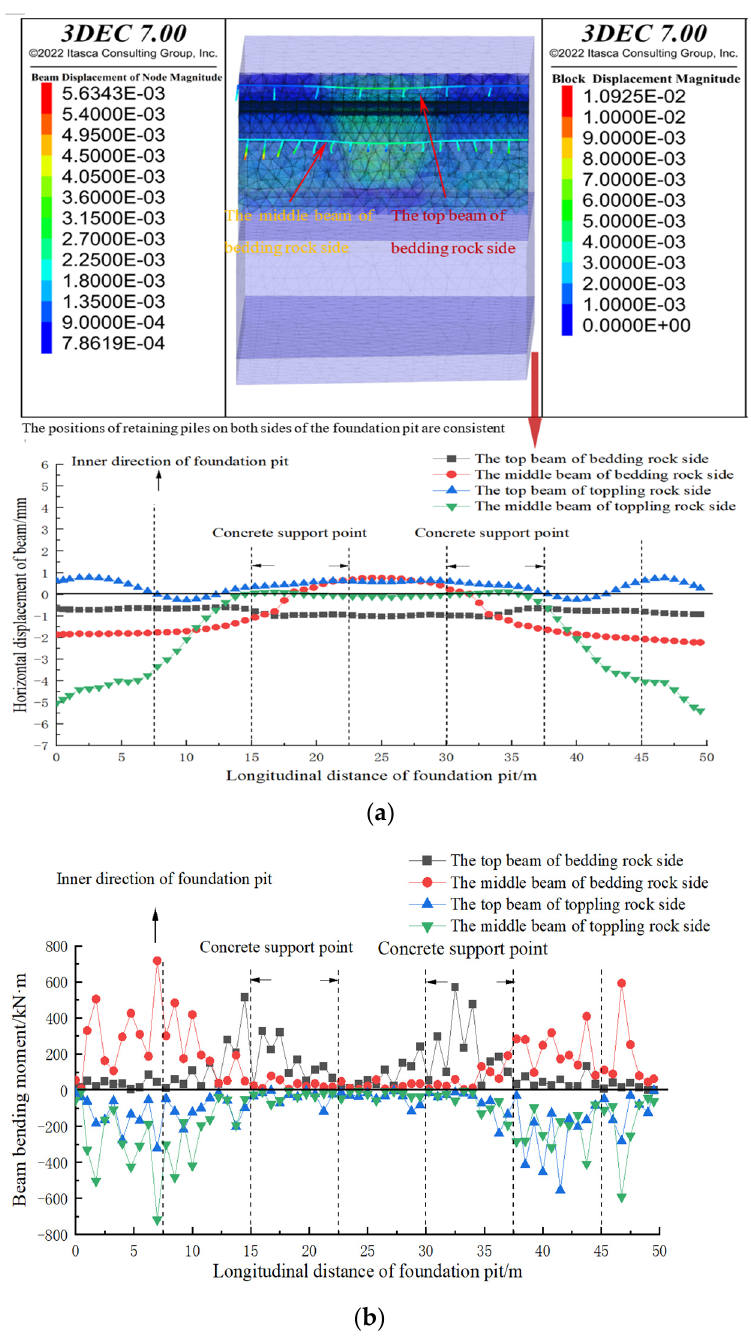
Figure 12. Analysis on the stress of pile-bracing support with 1.5 times pile spacing (analysis on the support beam). ( a ) displacement of support beam; ( b ) bending moment of support beam.